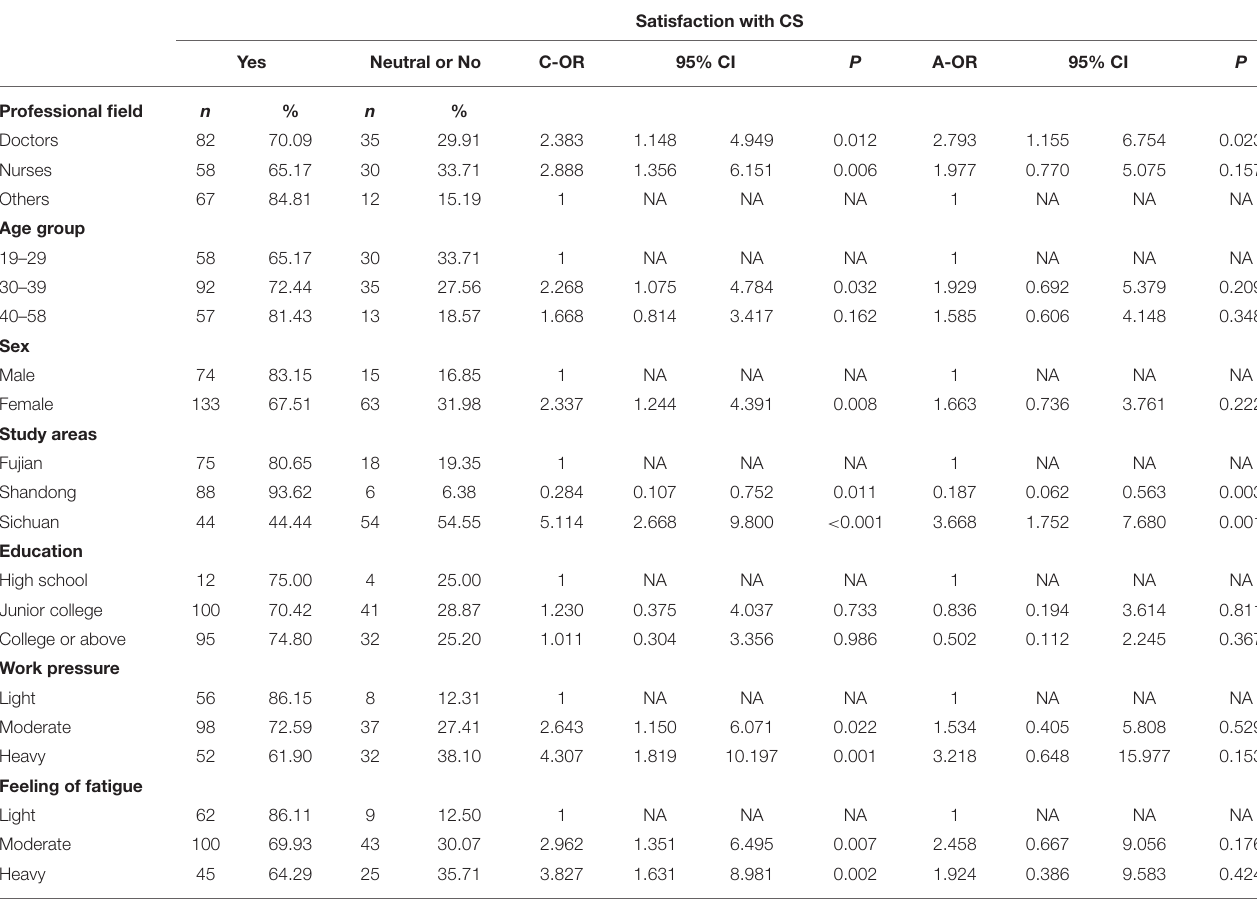
TABLE 4 | Potential influence factors of satisfaction with CS among general medical practitioners*.